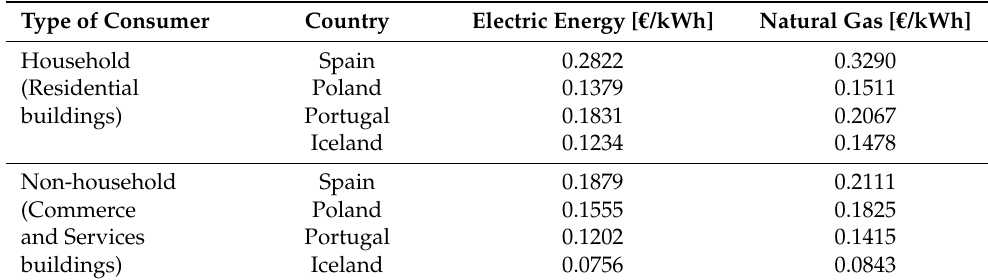
Table 6. Electric energy and natural gas tariffs in the first semester of 2022 for household or non- household consumers [45,46] (VAT not